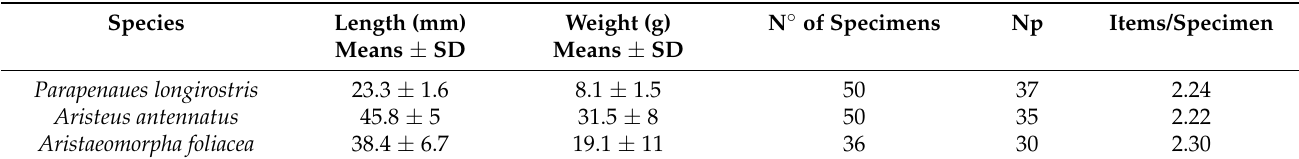
Table 1. Morphometric data of the analyzed crustacean species collected from the south-western Ionian Sea and the corresponding levels of particle contamination. N: number of specimens examined; Np: number of samples with detected particles.